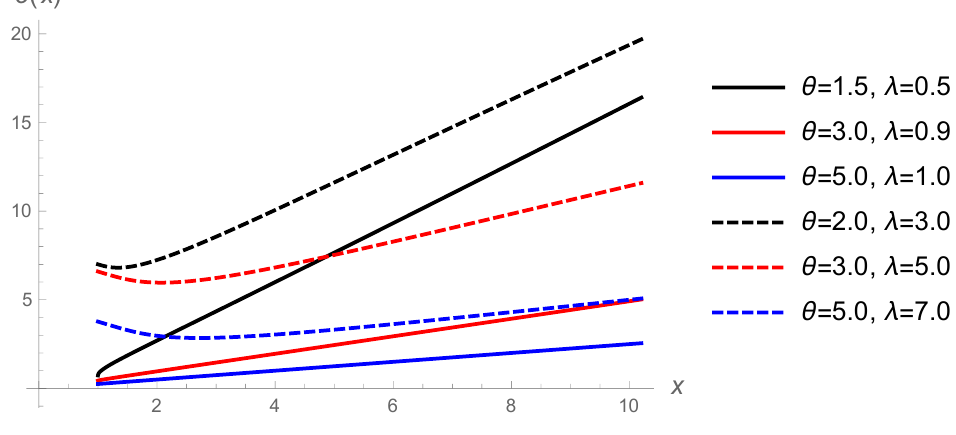
Figure 3. Mean residual life function of GTLG distribution for selected values of θ and λ when α =